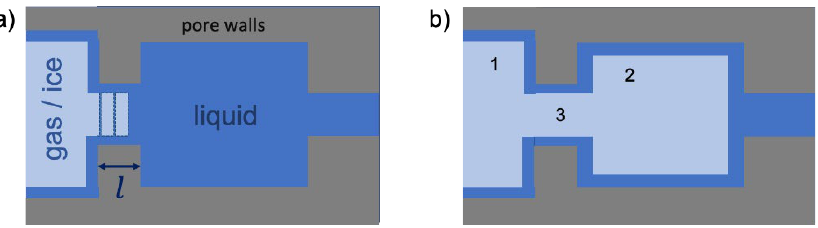
Figure 3. A schematic showing a part of a pore network in which a pore 1 containing either gas or ice phase is connected to a pore 2 with the capillary-condensed liquid via a smaller neck 3 with a length l. In ( a ), the positional gas/ice–liquid interface fluctuations in the neck are indicated. If their amplitude exceeds the neck length l, then the system jumps from a higher energy ( a ) to a lower energy ( b ) stable configuration.